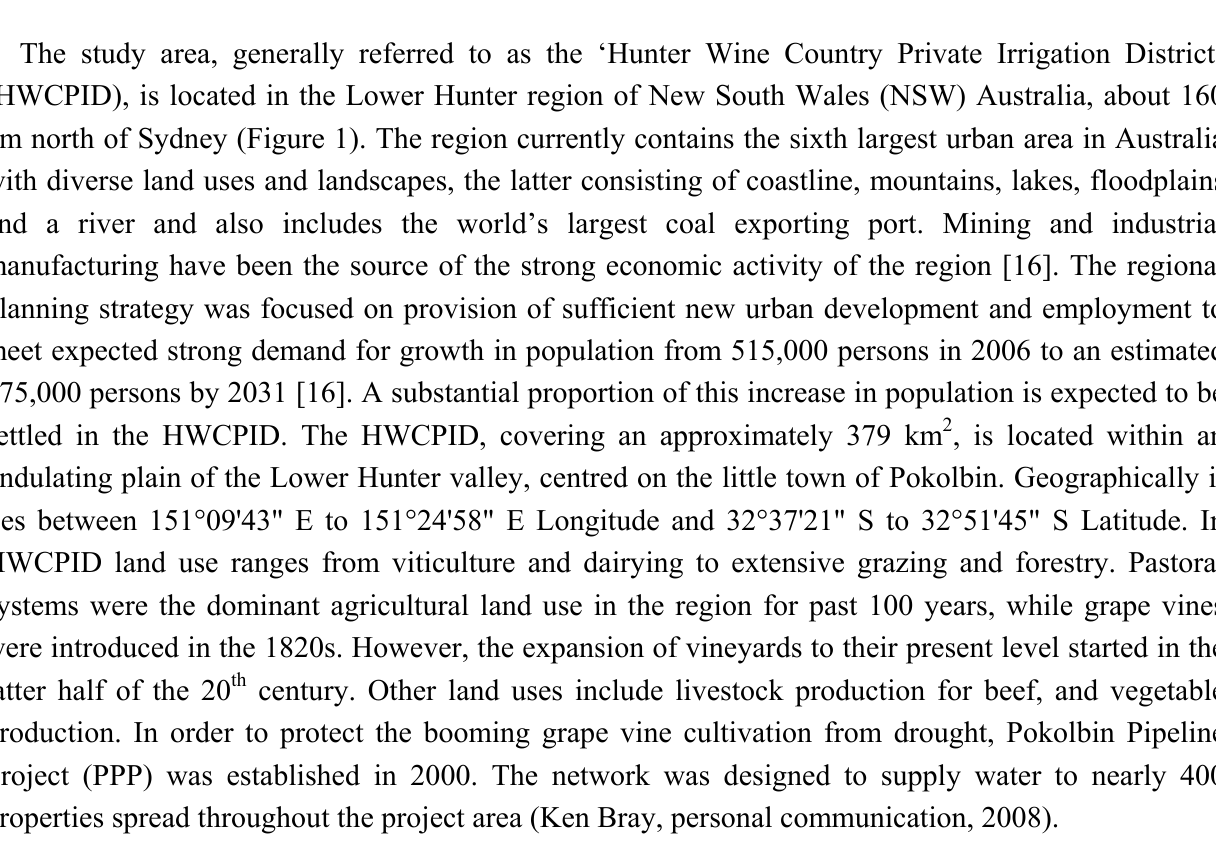
Figure 1. Location of study area (HWCPID) in New South Wales as a Landsat TM image of 2005 (in RGB combination of bands 4, 3 and